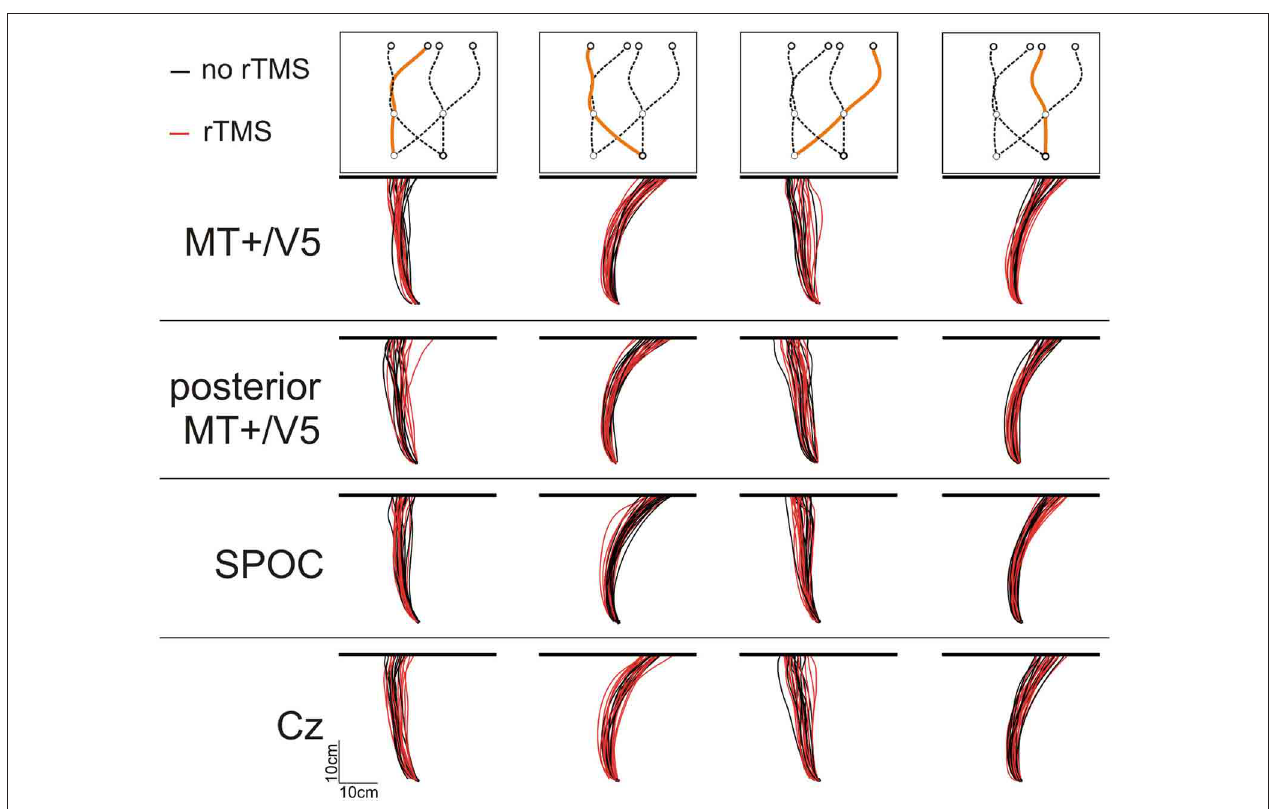
posterior MT + /V5, SPOC, and Cz), and four combinations of target position at initiation and interception (illustrated above the